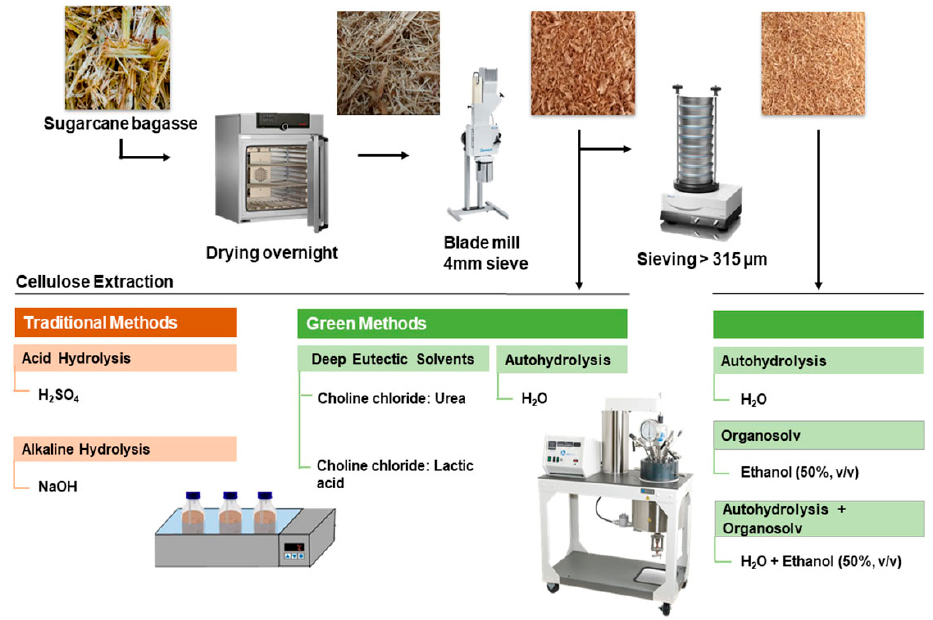
Figure 1. Schematic representation of sugarcane bagasse pretreatment and cellulose extraction methods tested.